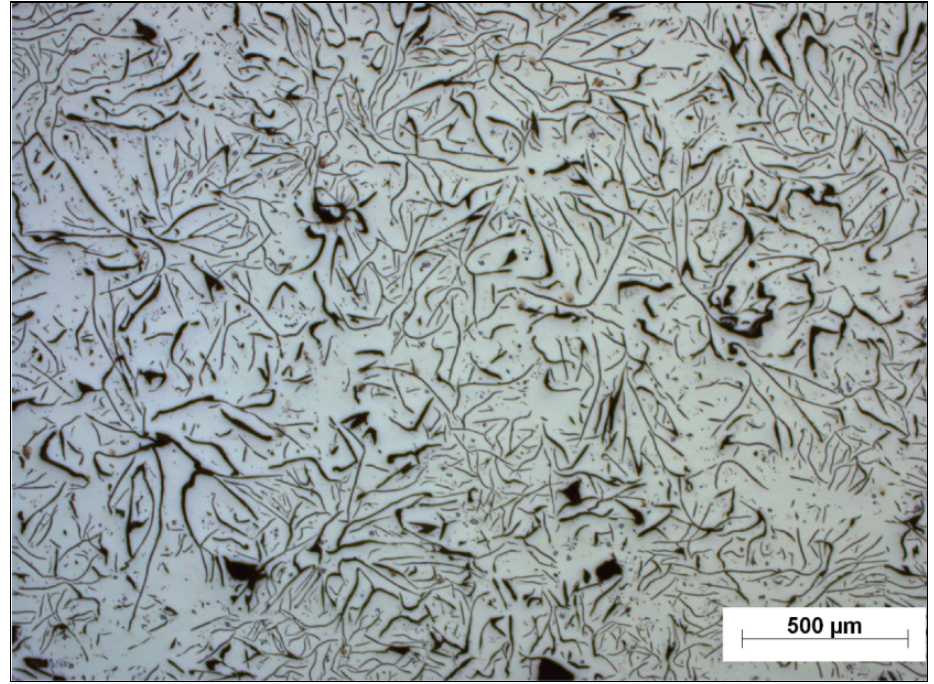
Figure 3. Micrograph of a specimen taken from a truck brake disc, made of a GG-15 material